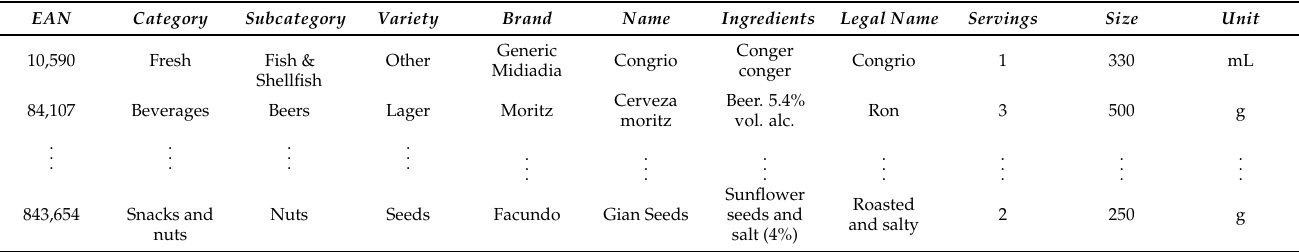
Table 1. Extract of the